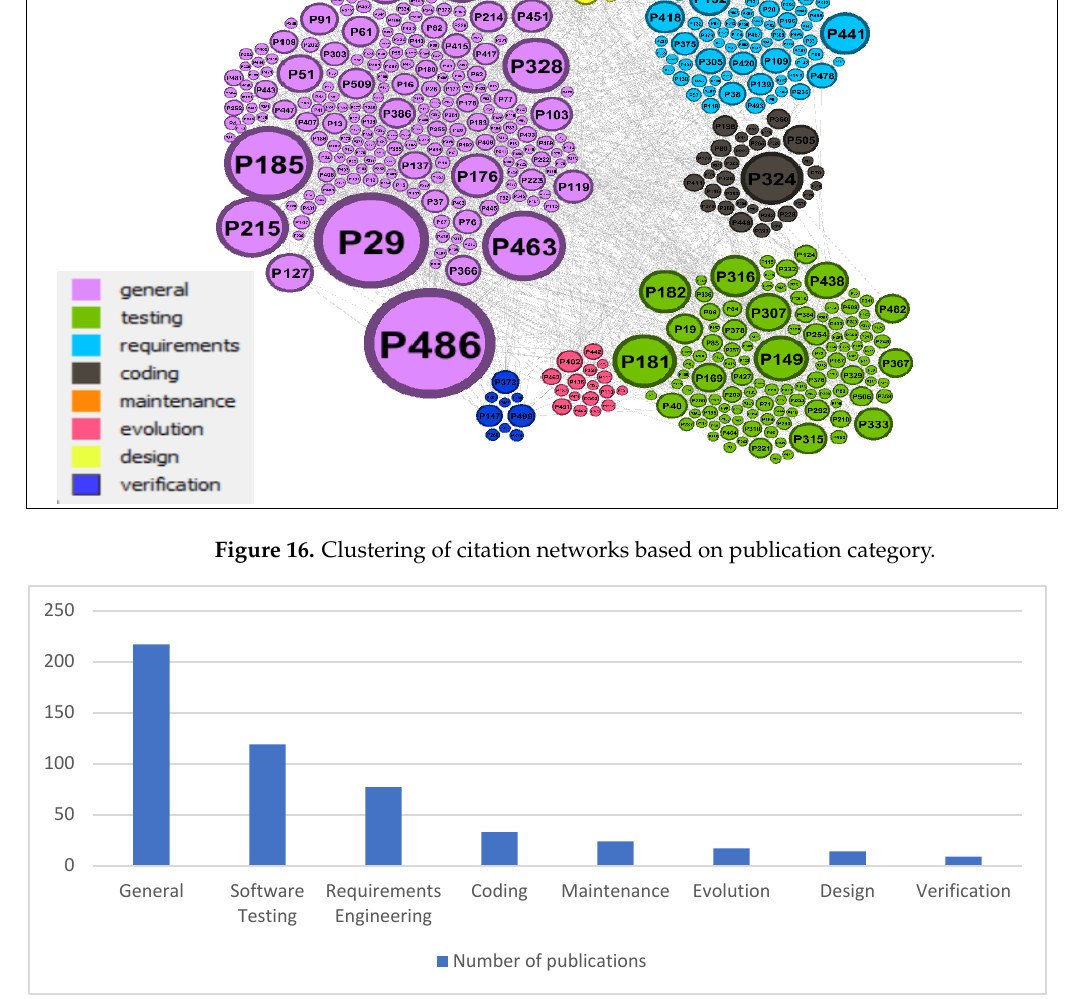
Figure 17. Number of publications in each category. Table 18. Summary of clusters of categories.